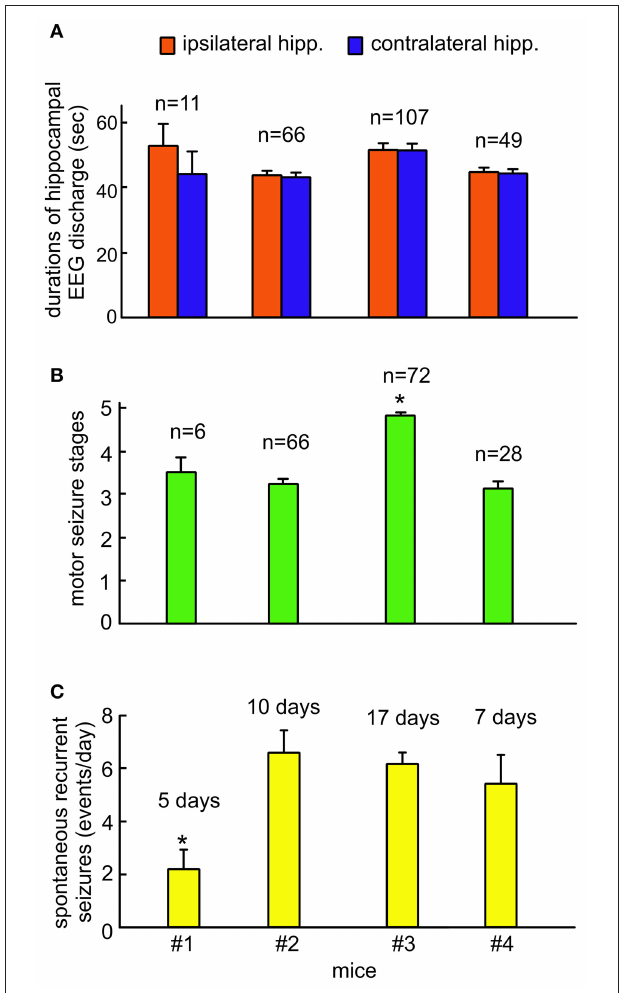
FIGURE 5 | Group measures of hippocampal EEG discharges, motor seizure stages and incidences of spontaneous recurrent seizures. Continuous EEG-webcam monitoring for 5–9 consecutive days was conducted in 4 mice following extended hippocampal kindling. Mice #2 and #3 underwent two monitoring sessions that were 15–30 days apart. Data are presented as means and standard errors of mean. Sample sizes for each measure indicated. (A) The durations of ipsilateral and contralateral hippocampal discharges measured from individual animals. (B) The stages of motor seizures corresponding to the hippocampal discharges measured from individual animals. Motor seizure scores for some of EEG discharges were not available due to errors in video data acquisition. (C) Daily incidences of spontaneous recurrent seizures measured from individual animals. These seizures were determined largely by bilateral hippocampal discharges and concurrent stage 3–5 motor seizures. *Significantly different vs. others, p < 0.05, one way